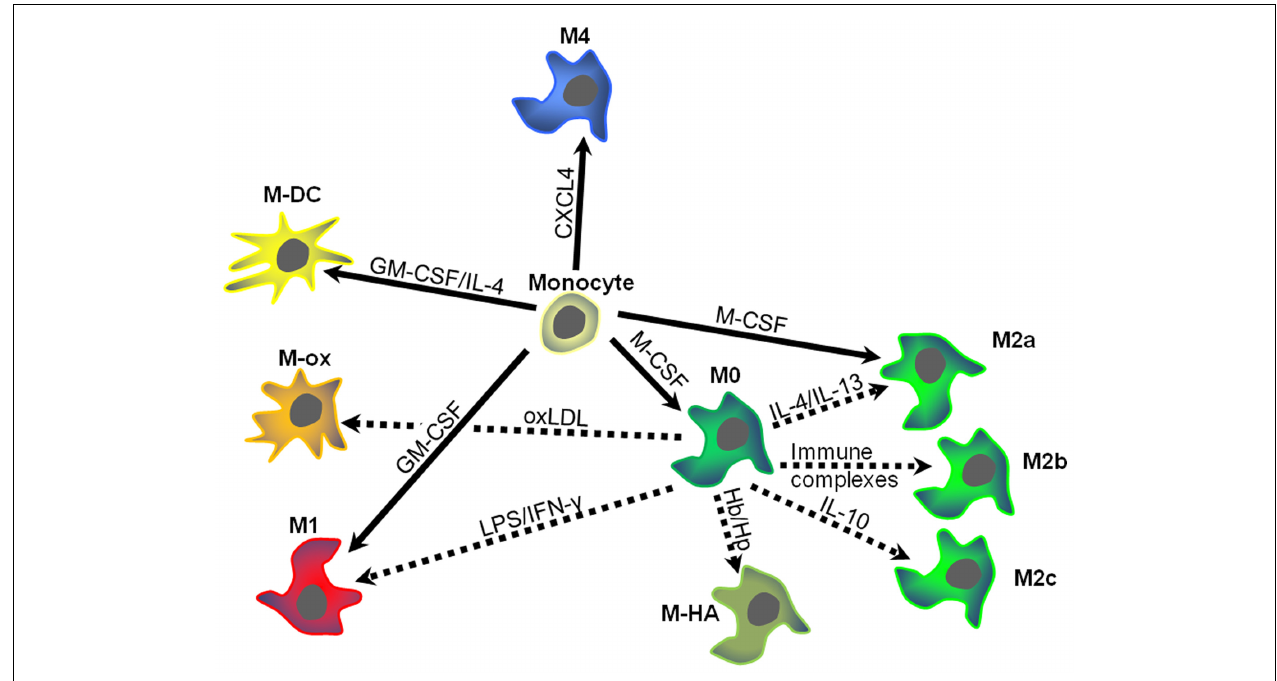
polarization. Colors and distances indicate similarities and differences between the different macrophage types. M-DC, dendritic cells; M-ox, foam cells induced by oxidized low density lipoprotein (oxLDL); M-HA, hemorrhage-associated macrophages. CXCL4, platelet factor 4; GM-CSG, granulocyte–macrophage colony-stimulating factor; Hb/Hp hemoglobin–haptoglobin complexes; IFN- γ , interferon-gamma; IL, interleukin; LPS,